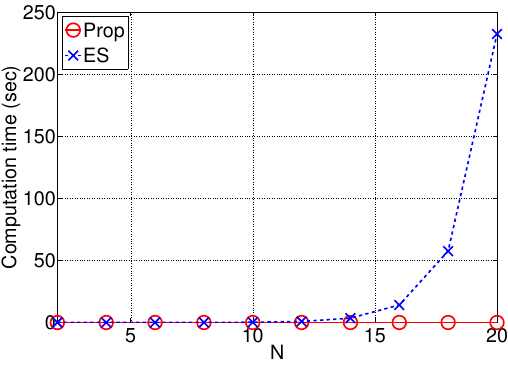
Figure 8. Computation time vs. N